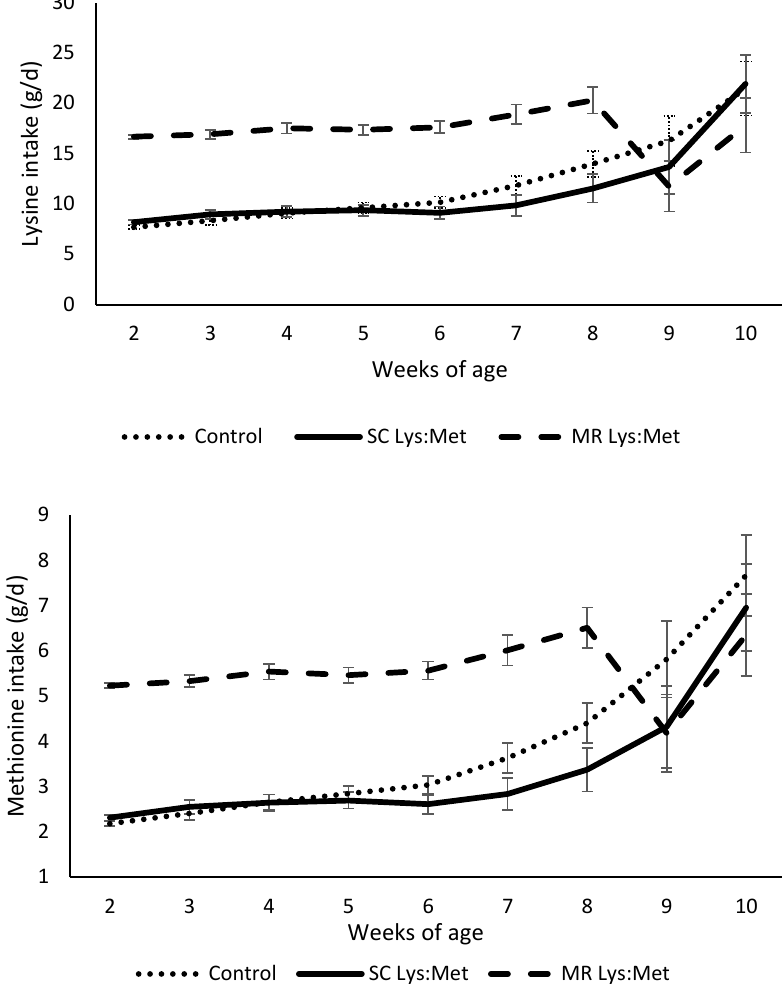
Figure 2. Lysine and methionine intake of dairy calves with or without lysine and methionine supplementation in starter concentrate or milk replacer. Calves fed milk replacer supplemented with Lys and Met, presented a higher intake of both amino acids during the pre-weaning period (week 2 to 8) with p < 0.01. Error bars indicate standard error of the mean.